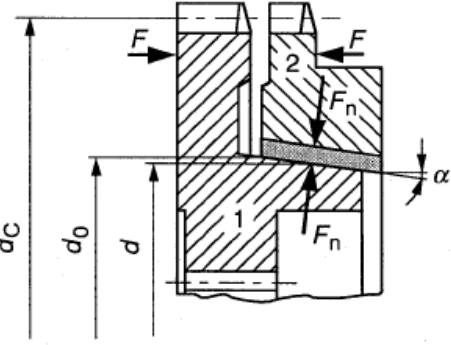
Figure 3. Schematic diagram of the force of the synchronizer.